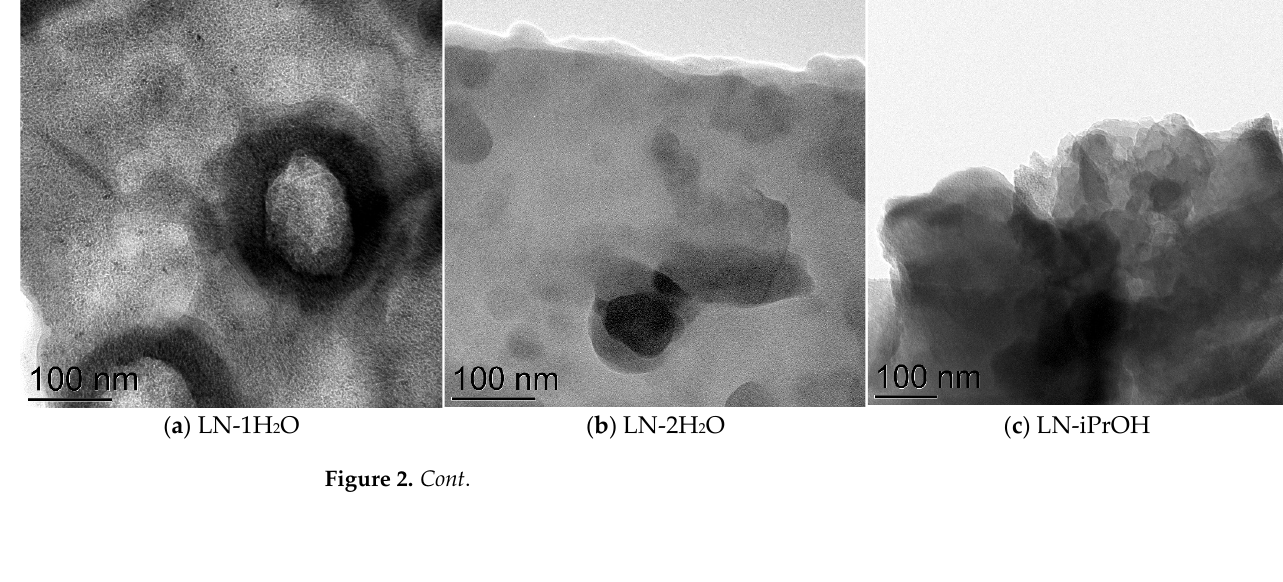
catalytic reaction can be proposed.